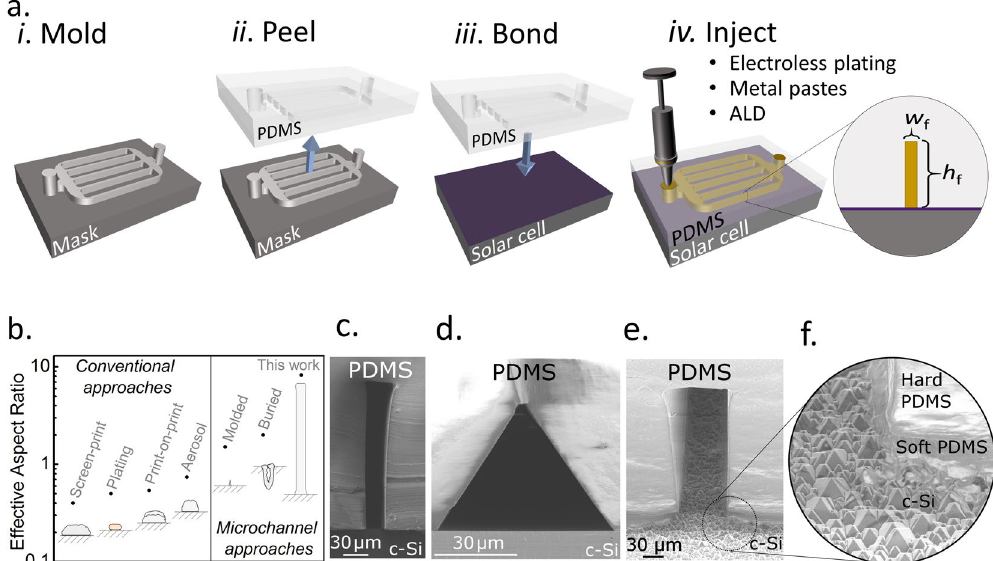
Figure 1. Microchannel contacted solar cell concept. ( a ) Basic fabrication procedure for microchannel contacted solar cells, ( b ) Comparison of aspect-ratio for conventional and microchannel based solar cell contacts, the individual figures approximately reflect their size relative to each other. Cross sectional SEM images of ( c ) high aspect-ratio microchannel (90° cross section); ( d ) triangular microchannel (90° cross section); ( e ) textured surface bonding (45° cross section); and ( f ) magnified bonding to textured surface (45° cross